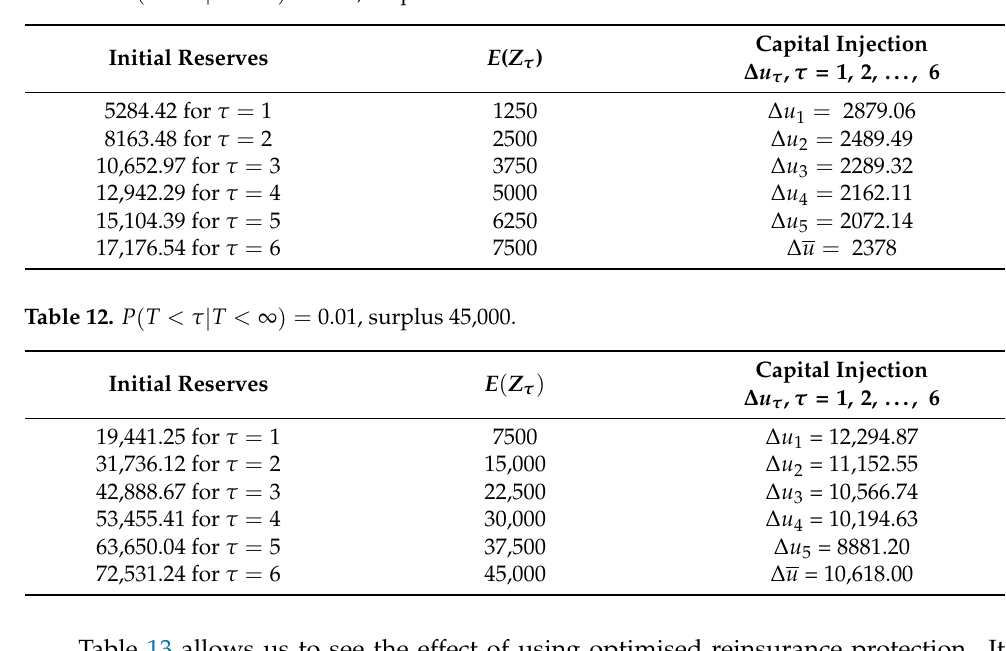
Table 11. P ( T < τ | T < ∞ ) = 0.01, surplus 7500.